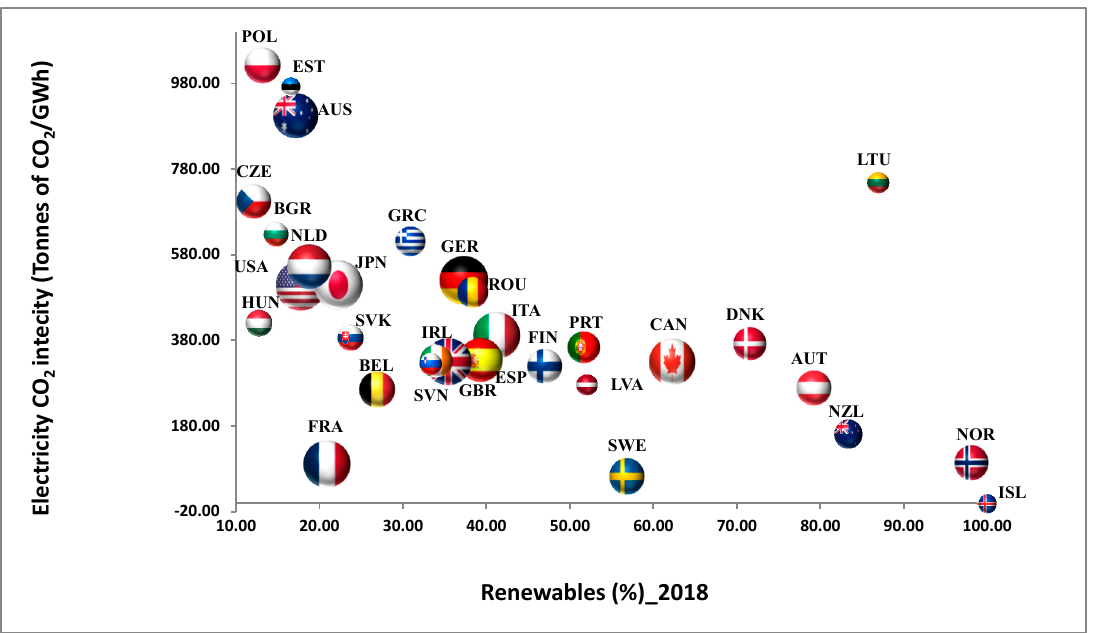
Figure 1. Electricity CO 2 intensity vs. Renewables (%) Year _1995. Note: Sphere size is determined based on each country’s Total GDP ranking in the dataset. Authors’ elaboration. Data sources: [49], [52– 55].